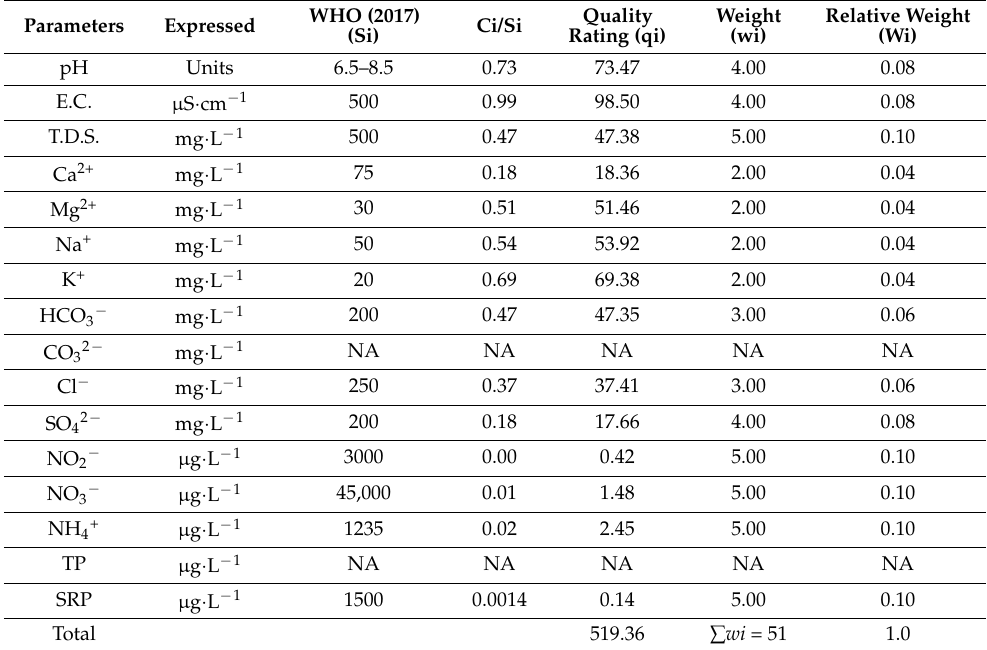
Table 2. Assigned and relative weight of water quality variables for Water Quality Index computation with WHO [55].